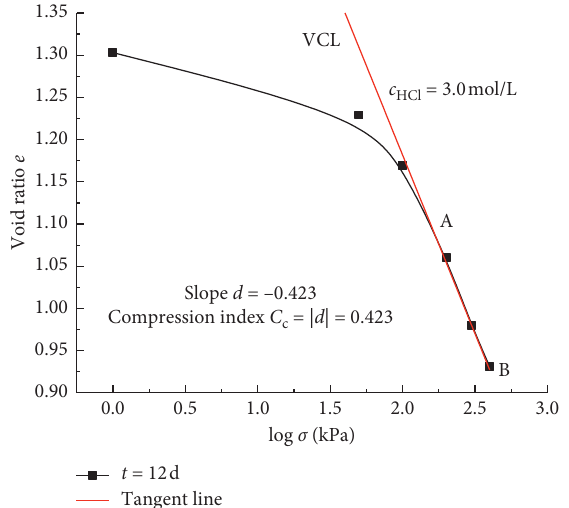
Figure 3: The method of calculating the slope of the compression index C c .